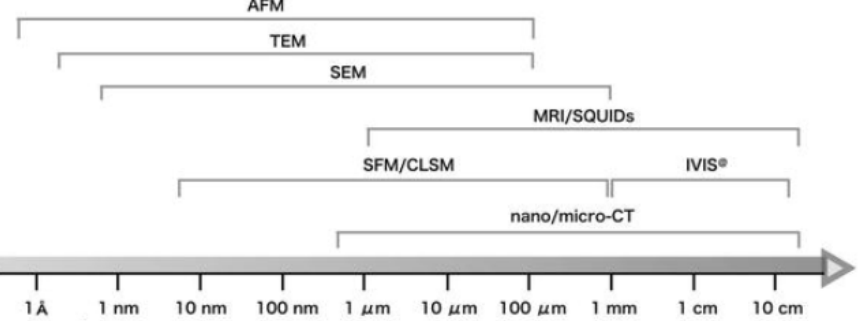
Figure 9. Di ff erences between optical microscopy, SEM, TEM, and atomic force microscopy (AFM) in Figure 9. Differences between optical microscopy, SEM, TEM, and atomic force microscopy resolution [45]. Membranes 2020 , 10 , 33 (AFM) in resolution [45].